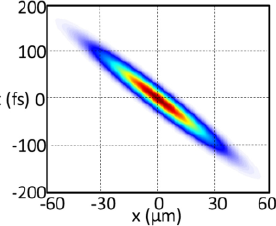
Figure 3. The simulation result of PFT (pulse front tilt) in the focal plane of an SSTF pulse. X refers to the direction of the spatial chirp. Reproduced with permission from [30], Copyright The Optical Society, 2014.